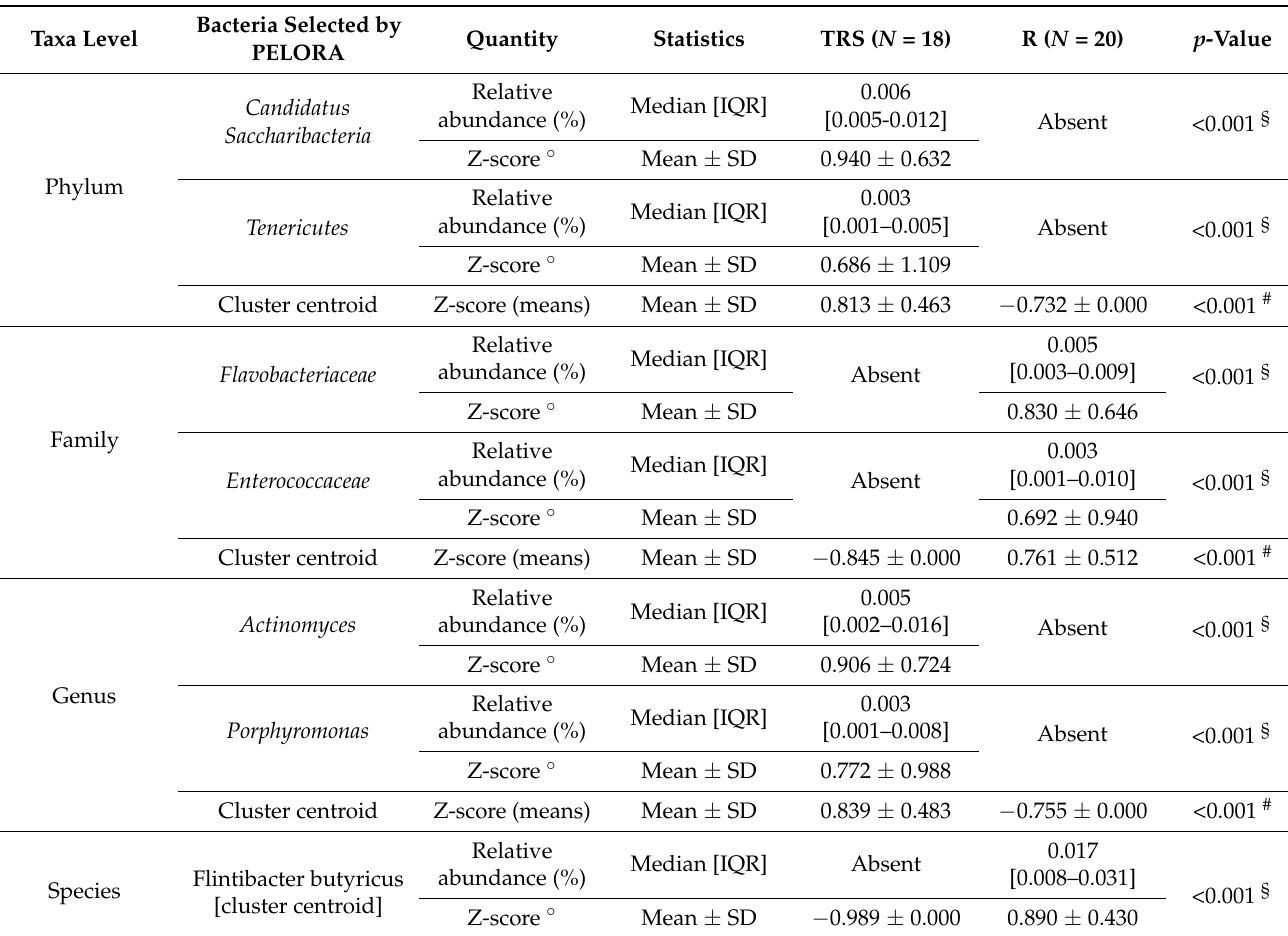
Table 3. Results from Penalized Logistic Regression Analysis (PELORA) algorithm which identifies panels of bacterial populations that best discriminate TRS and R